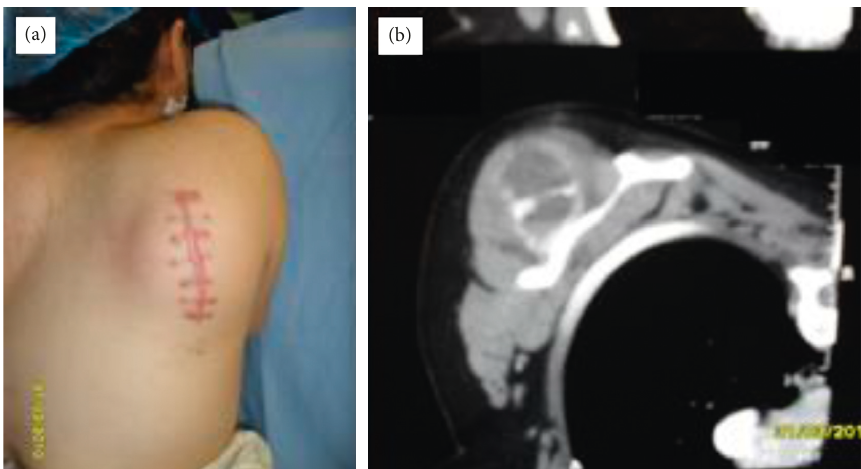
Figure 1: (a) Posterior Scapular mass with broad scar after resection attempt. (b) Axial CTshowing soft tissue mass extending posterior to the